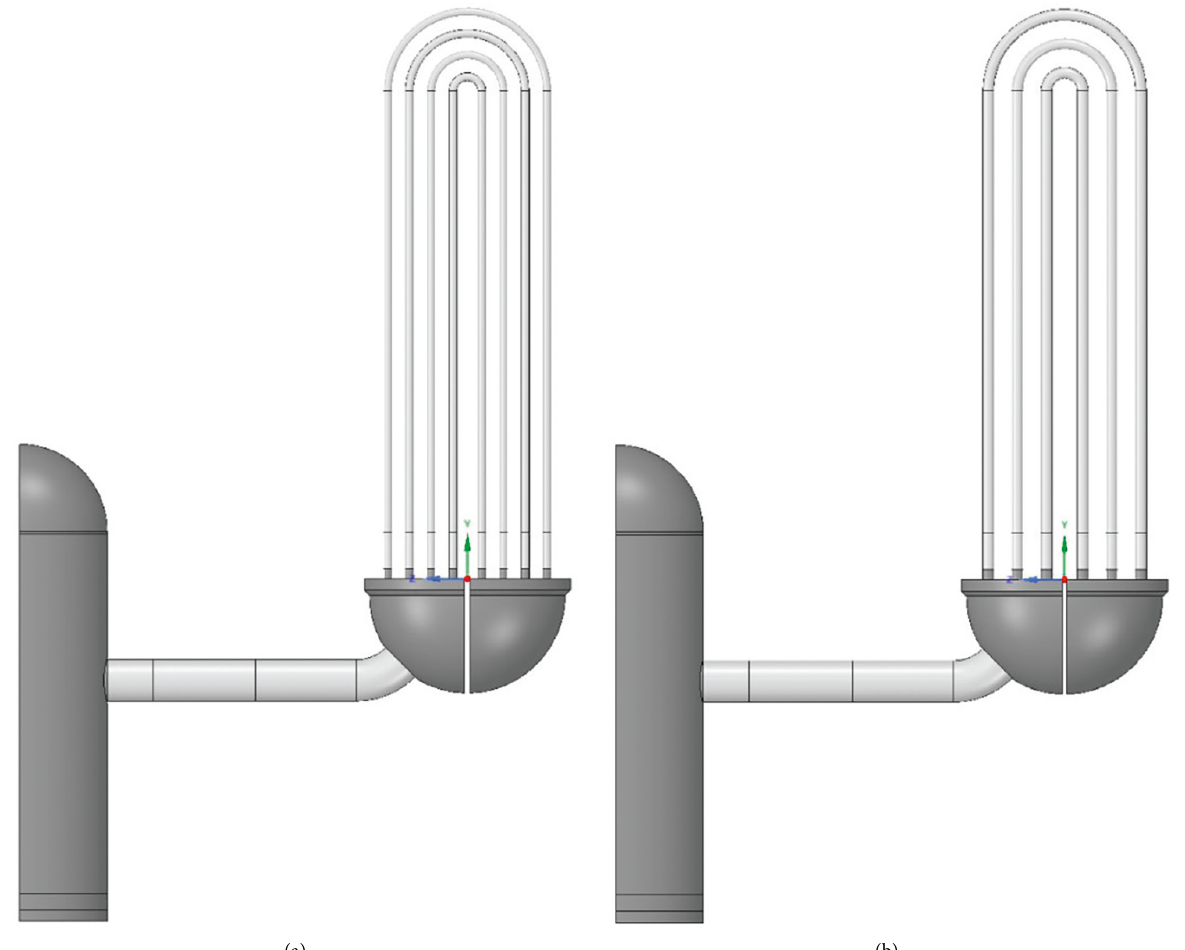
Figure 9: CAD model of simplified tube in the steam generator. (a) Model 2 and (b) model 3.